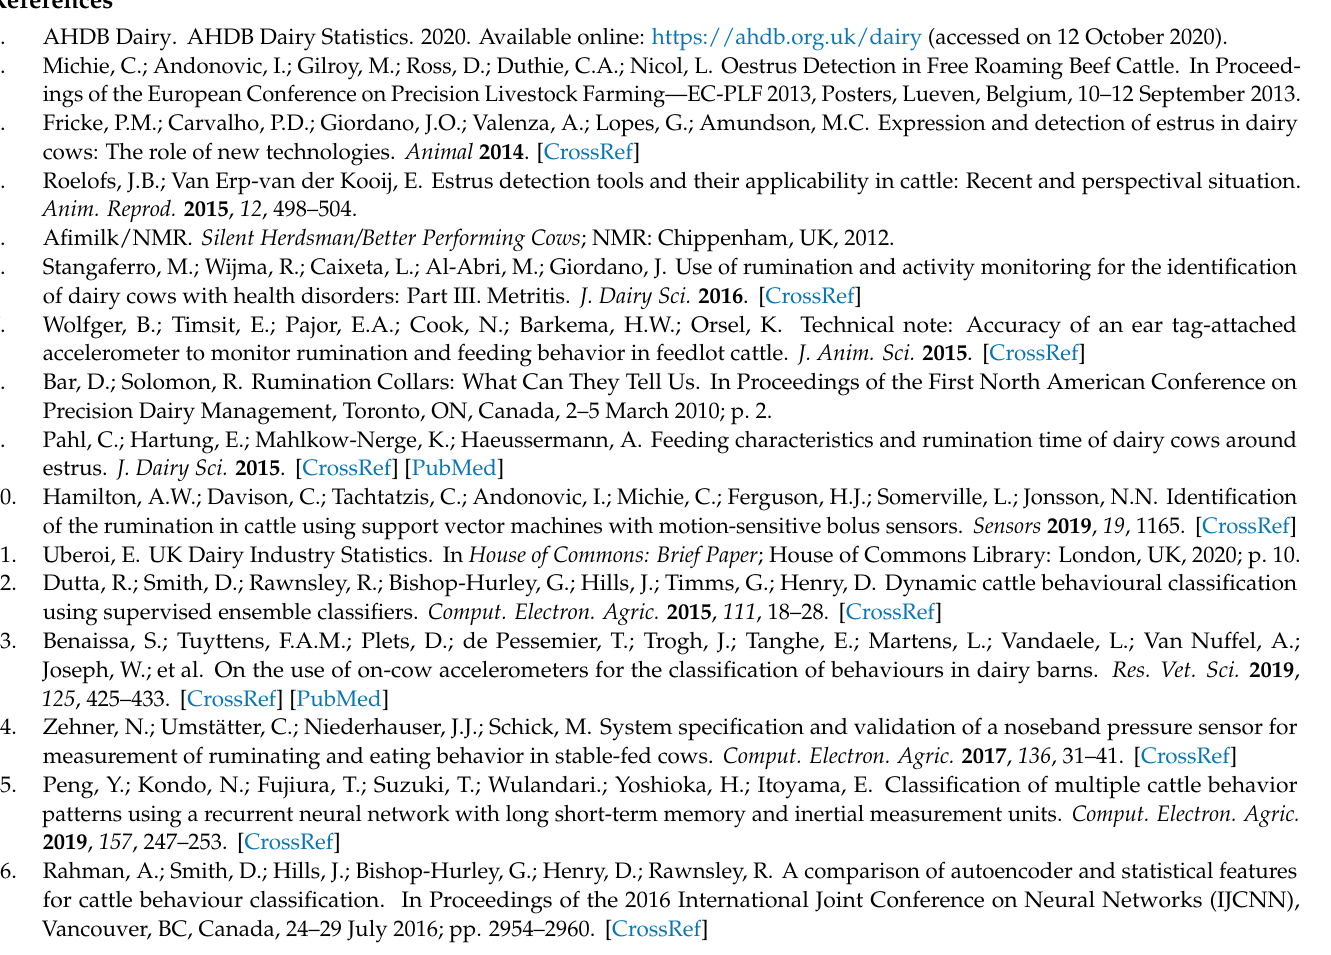
Table A1. Related work: Cattle behaviours. Cattle Behaviours Abell et al. (2017) [18] Lying, Mounting, Standing & Walking Benaissa et al. (2019) [13] Feeding, Lying & Standing Benaissa et al. (2019) [19] Feeding, Ruminating & Other Diosdado et al. (2015) [20] Feeding, Lying, Standing & Transitions between Standing and Lying Dutta et al. (2015) [12] Grazing, Resting, Ruminating, Scratching or urinating & Searching Gonzalez et al. (2015) [17] Foraging, Resting, Ruminating, Traveling & Other active behaviors Hamilton et al. (2019) [10] Rumination & Non-Rumination Kasfi et al. (2016) [21] Grazing & Other Feeding, Lame Walking, Lying, Lying down, Ruminating, Standing, Martiskainen et al. (2009) [22] Standing up & Walking normally Feeding, Head butt, Licking salt, Lying, Moving, Ruminating-Lying, Peng et al. (2019) [15] Ruminating-Standing & Social licking Chewing, Grazing, Resting-Lying, Resting-Standing, Ruminating-Lying or Rahman et al. (2016) [16] Sitting, Ruminating-Standing, Searching, Walking & Other Rahman et al. (2018)